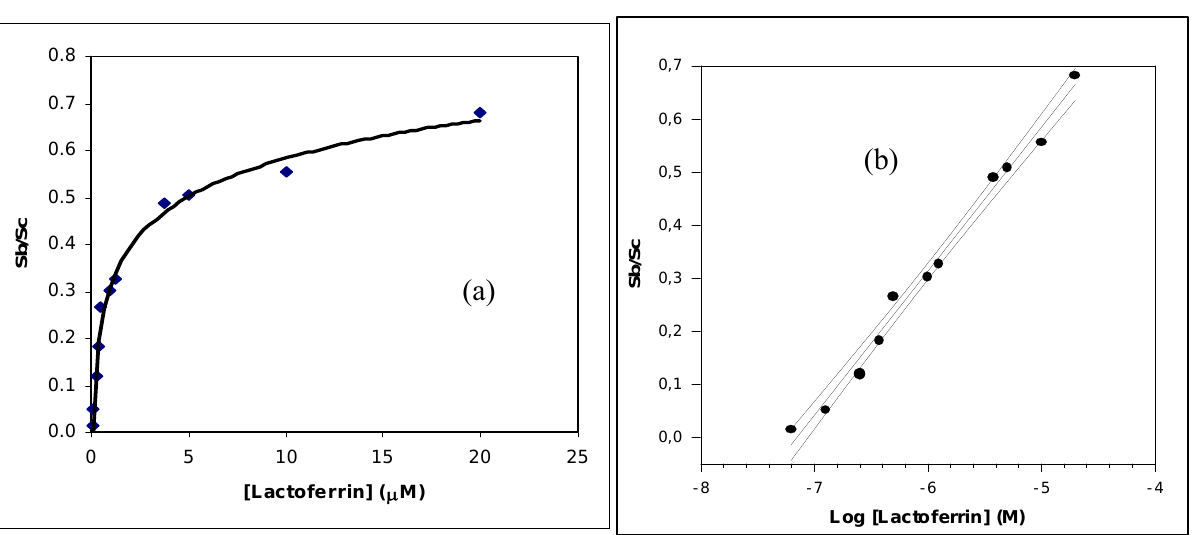
Figure 4. (a) Behaviour of the lactoferrin immunosensor response as a function of increasing lactoferrin concentration, using Immobilon membrane and an amperometric electrode for H O as transducer; (b) corresponding calibration curve and confidence 2 2 interval for the lactoferrin determination, (Sc = sample signal/nA; Sb = blank